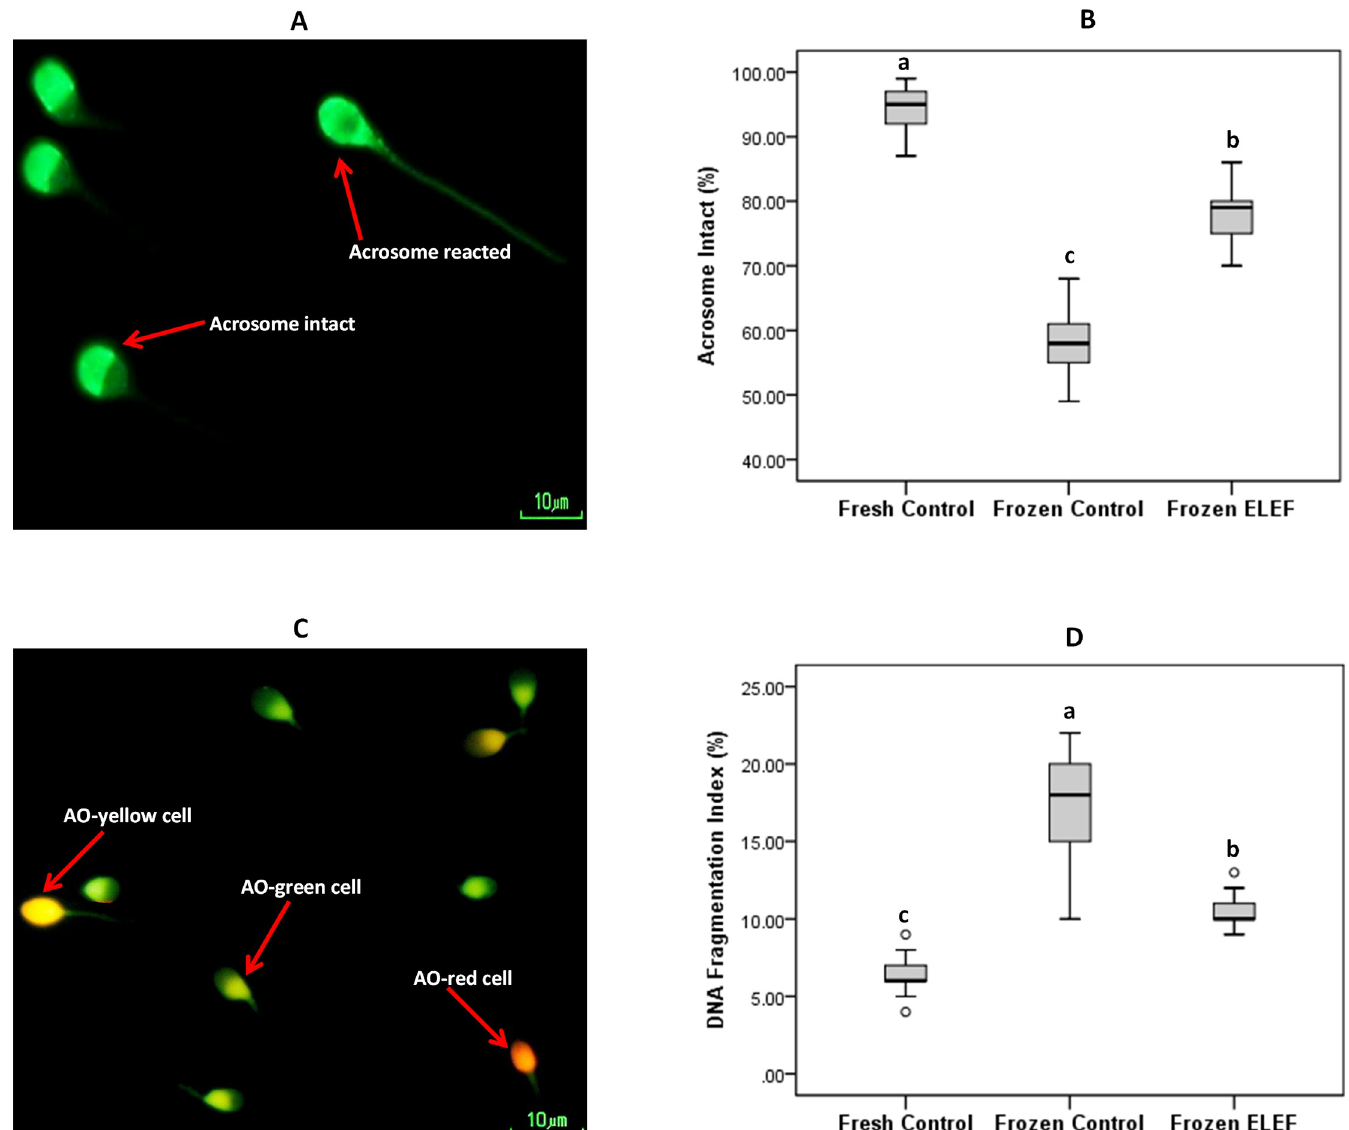
Fig 7. Acrosome integrity and sperm DNA fragmentation. (A) Acrosome evaluation was detected using FITC-PSA staining; acrosome intact and acrosome-reacted are shown. (B) Box-and-whisker plots for sperm with acrosome intact from the three experimental groups show the significant differences among all groups (C) Acridine orange test in human sperm; sperm heads with double-stranded DNA were green (AO-green cells) and sperm heads with single-stranded DNA were red or yellow (AO-red or AO-yellow cells). (D) Box-and-whisker plots for DNA fragmentation index of sperm from the three experimental groups. The higher DNA fragmentation index is observed in frozen control as compared to fresh control and frozen ELEF. The assigned letters of a, b and c indicate significant differences (p < 0.05) among the groups. Values are expressed as mean ± SD. https://doi.org/10.1371/journal.pone.0221976.g007 Table 4. Staining of sperm by Annexin V and propidium iodide (PI). The assigned letters of a, b and c indicate significant differences (p < 0.05) among the groups. Val- ues are expressed as mean ± SD, Tukey test. An - /PI - , live cells; An + /PI - , early apoptotic cells; An + /PI + , late apoptotic cells; An - /PI + , necrotic cells.